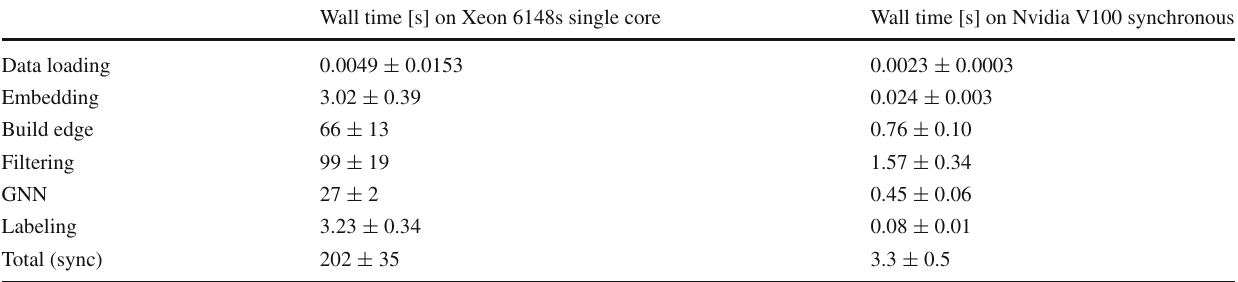
Table 2 Average inference time for synchronous execution of the TrackML pipeline benchmarked on CPUs and GPUs. For these step-by- step measurements, we force the pipeline to execute serially by